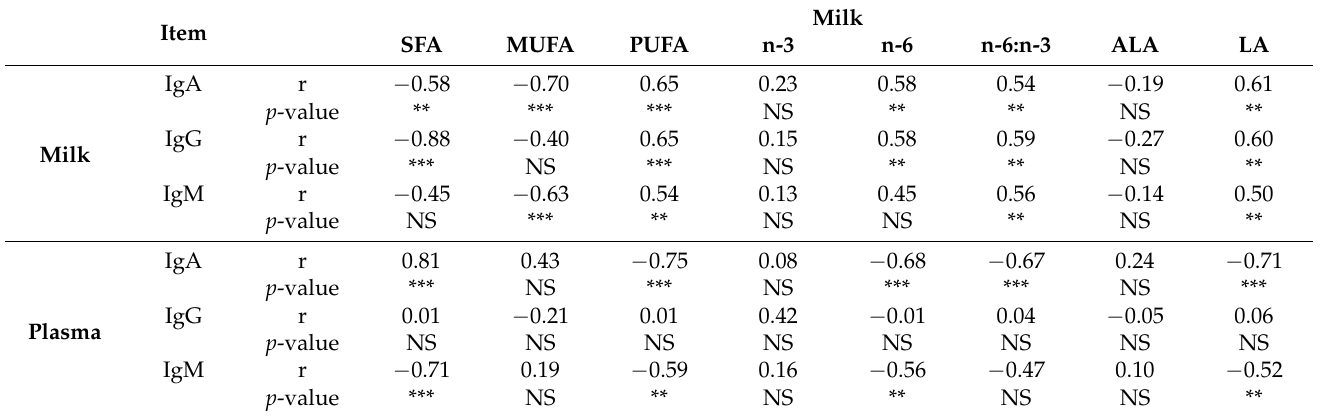
Table 7. Spearman coefficient correlation between Ig of plasma and milk from sows and FA.